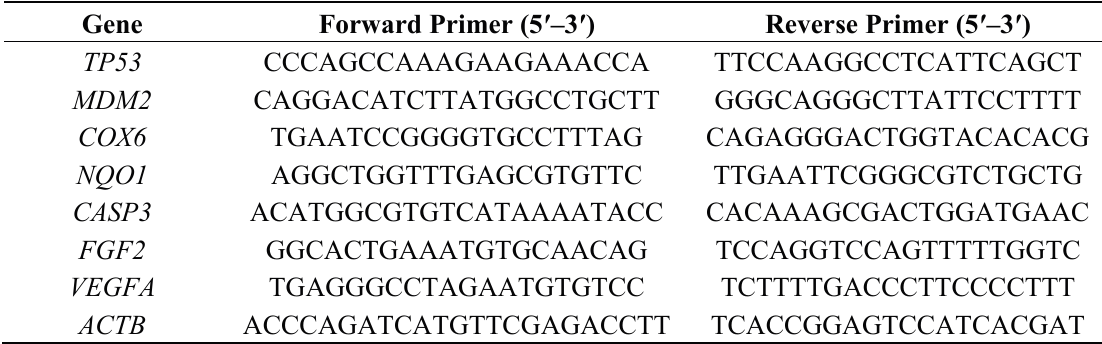
Table 3. Primers used in the